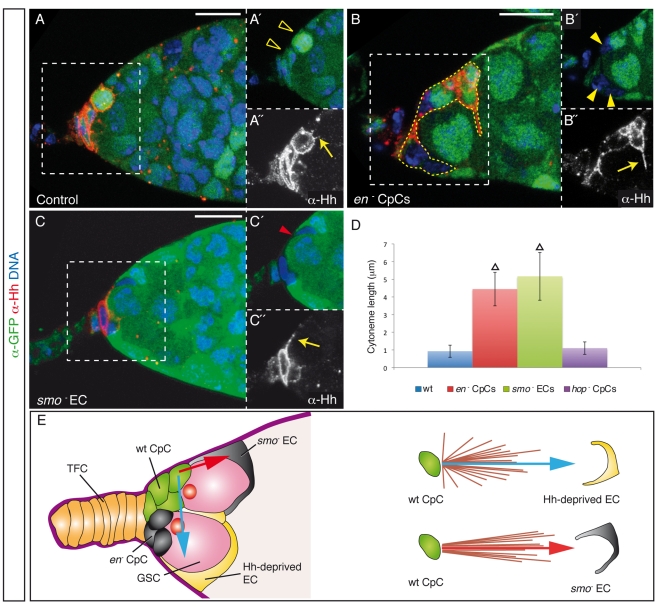
Cytoneme-mediated delivery of Hh in the niche.(A) Control germarium showing the typical short cytonemes found in CpCs of wild-type niches. (B) Mosaic germarium containing several en
E mutant CpCs and displaying a Hh-coated long cytoneme that originates from a wild-type CpC. (C) A Hh-rich long cytoneme projecting from a wild-type CpC towards a smo
D16 mutant EC. (D) Bar chart representing the mean cytoneme length (± s.d.) in control germaria with wild-type (wt) niche cells, and in mosaic germaria containing ≥3 en mutant CpCs, smo mutant ECs, or hopscotch mutant CpCs (see also Figure S7 and Tables S3 and S4). Somatic clones were induced with the bab1-Gal4 driver and were dissected 3 d after eclosion. Triangles indicate statistically significant differences (Student's t test, p<0.0005). (E) In order to determine whether the long cytonemes found in the above mosaic germaria projected randomly within the niche, we plotted the position of these cytonemes with respect to two arbitrary axes defined as follows. In each cytoneme-containing germarium, we have drawn a straight arrow that originates in the cytoneme-growing CpC and that is oriented towards either the EC in contact with en mutant CpCs (n = 18; blue arrow) or the smo mutant EC (n = 11; red arrow). Our analysis shows that cytonemes grow directionally in the direction of the ECs in contact with en mutant CpCs (“Hh-deprived ECs”) or towards the smo mutant ECs, strongly suggesting that these long filopodia sense, and project to, the signalling-deficient region of the niche. Yellow open arrowheads, wild-type CpCs; yellow arrowheads, en mutant CpCs; red arrowhead, smo mutant EC; yellow arrows, Hh-coated cytonemes; yellow dashed line, CpC cluster. Scale bars: 10 µm.